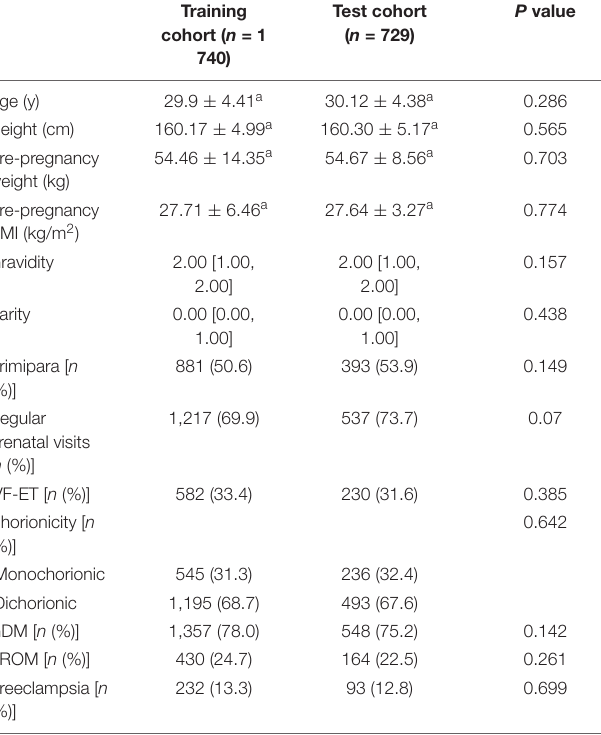
TABLE 1 | Clinical characteristics of the training and test cohort.